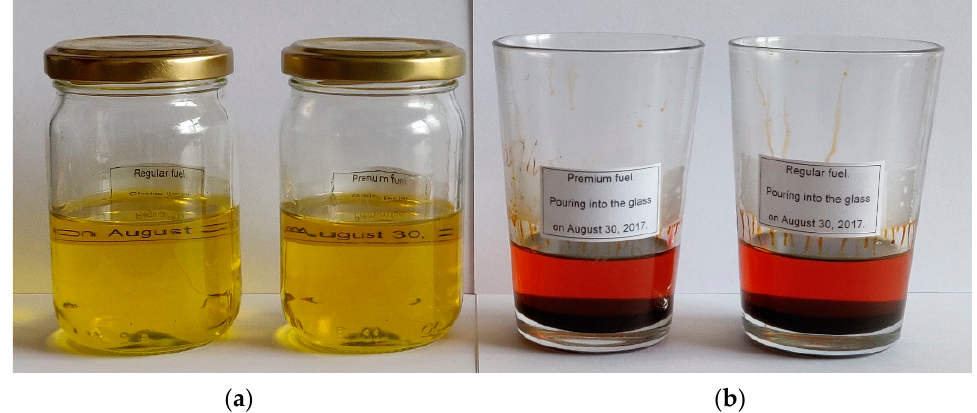
Figure 2. Premium and regular fuels stored in an optical darkroom for five years: ( a ) in closed jars; ( b ) in open glasses. Table 2. Measured parameters of summer fuels used in this